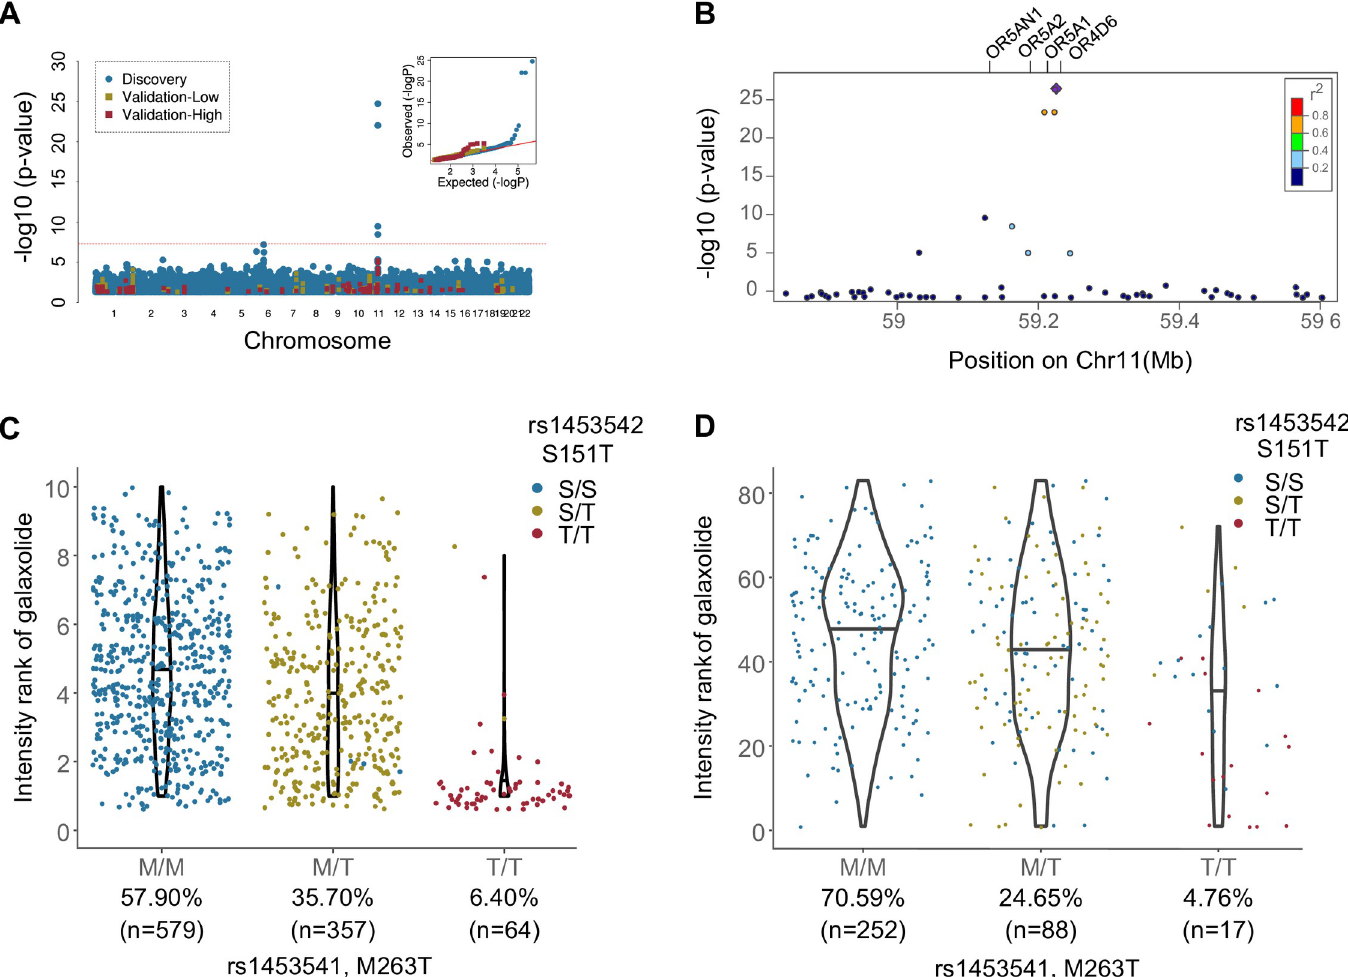
Fig 3. Galaxolide perception is associated with variation in chromosome band 11q12.1 in both cohorts , as shown by A) a Manhattan Plot of associations with the discovery study in blue and validation study in red (high concentration) and yellow (low concentration). The red line indicates the threshold for genome-wide significance (p < 5x10 -8 ). Inset: QQ plots from the discovery (blue) and validation ([high] = red, [low] = yellow) cohorts (Genomic Lambda: discovery = 1.02; validation = 0.90) show appropriate control for inflation due to population structure. B) The regional plot of discovery study associations indicates both the significance level and the recombination rate at the OR4D6 LD-band. Genetic variation in OR4D6 affects the perceived intensity of Galaxolide in C) the discovery cohort and D) the validation cohort (high concentration). The x-axis is ordered left-to-right with increasing number of variant alleles for the M263T variant, for population frequency of M263T indicated below the genotype. The points colored by the S151T genotype suggest that in the validation cohort, S151T is driving the Galaxolide anosmia phenotype exhibited by those homozygous for the variant (T/T).